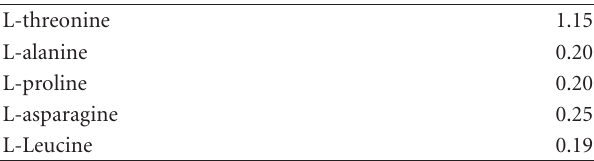
Table 5: Comparison of SHG e ffi ciencies of di ff erent organic NLO crystals relative to KDP equaling